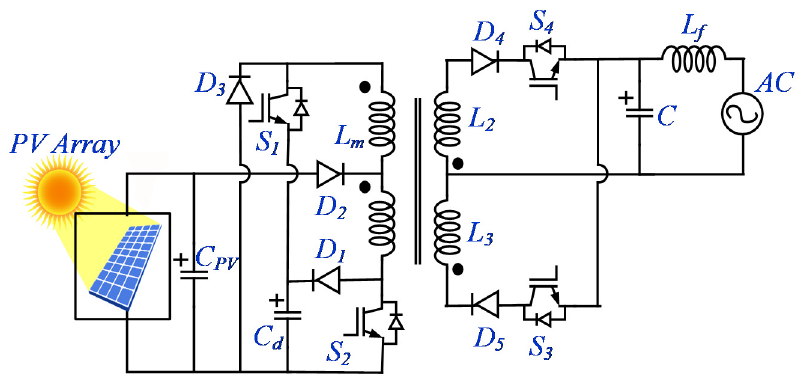
Figure 22. Three port fly-back inverter with coupling circuit-1 .